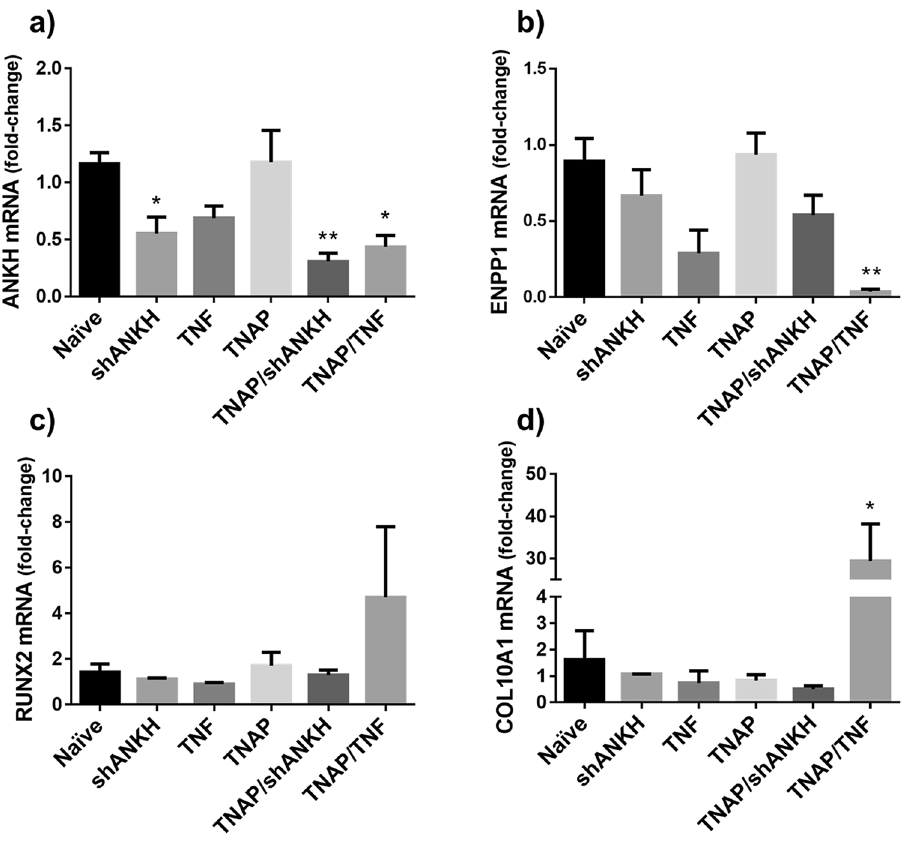
Figure 3. TNF down-regulates inhibitors of mineralization ( a ) ANKH, ( b ) ENPP1 and increases expression of hypertrophy markers, ( c ) RUNX2, ( d ) COL10A1 in TNAP transduced bNPs (n = 3). Data are mean ± S.E.M. of 3 experiments. Significance represents *p < 0.05 or **p < 0.005 compared to naïve cells. Data analyzed using One-way